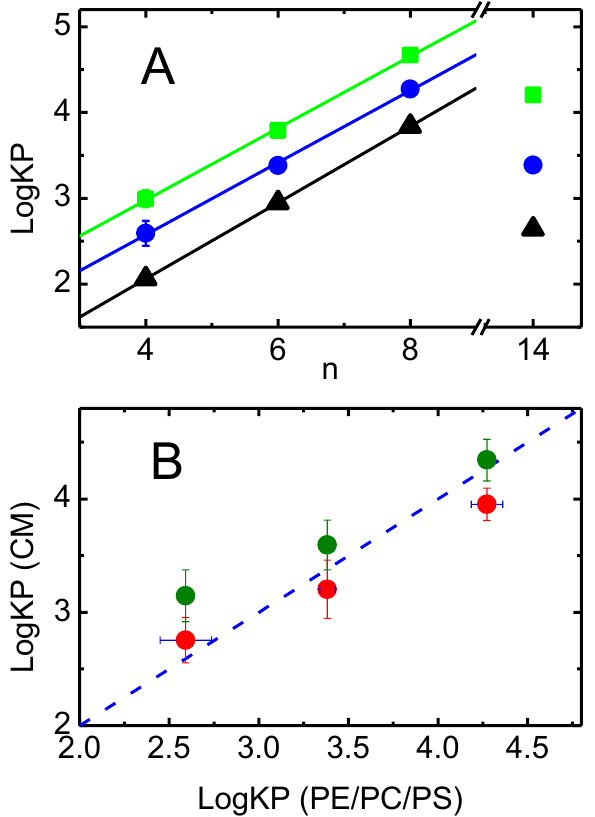
Figure 4. Lipophilicity of the NBD amphiphiles. Plot A : Dependence of the calculated LogD ( – , (cid:78) ) and experimental partition to lipid bilayer composed of POPC ( – , (cid:4) ) or PE:PC:PS 45:35:20 ( – , • ), with the length of the alkyl chain. Note the x-axis break between NBD–C8 ( n = 8) and NBD–LysoMPE ( n = 14). Plot B : Relation between the affinity of the NBD–Cn amphiphiles to the native membranes and to the representative model membranes, considering only the lipids, V M = V L ( • ) or both the lipids and the proteins V M = V L + V P ( • ). The identity line is also shown ( - - ). The symbols are the average of at least five independent measurements, and the standard deviations are also shown (some are smaller than the symbol